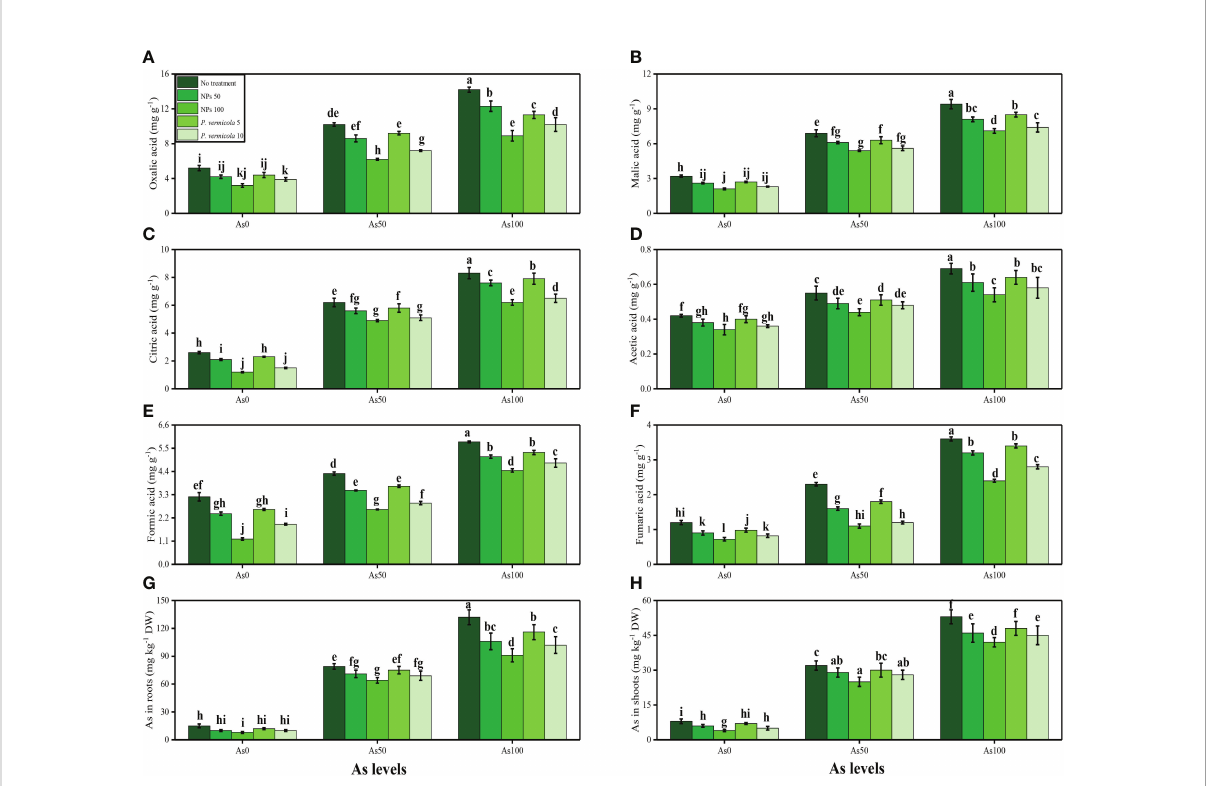
FIGURE 8 Effect of combined application of various levels of iron oxide nanoparticles (FeO-NPs) (i.e., 50 mg/l − 1 and 100 mg/l − 1 ) and plant growth- promoting bacteria ( Providencia vermicola ) (i.e., 5 ppm and 10 ppm) on oxalic acid contents (A) , malic acid contents (B) , citric acid contents (C) , acetic acid contents (D) , formic acid contents (E) , fumaric acid contents (F) , in the roots and As contents in the roots (G) , and As contents in the shoots (H) of Ajwain ( Trachyspermum ammi seedlings) grown under various stress levels of arsenic (i.e., 0 m M, 50 m M, and 100 m M). Values are demonstrated as means of four replicates along with standard deviation (SD; n = 4). Two-way ANOVA was performed and means differences were tested by Tukey ’ s highly signi fi cant difference post-hoc test ( p < 0.05). Different lowercase letters on the error bars indicate signi fi cant difference between the